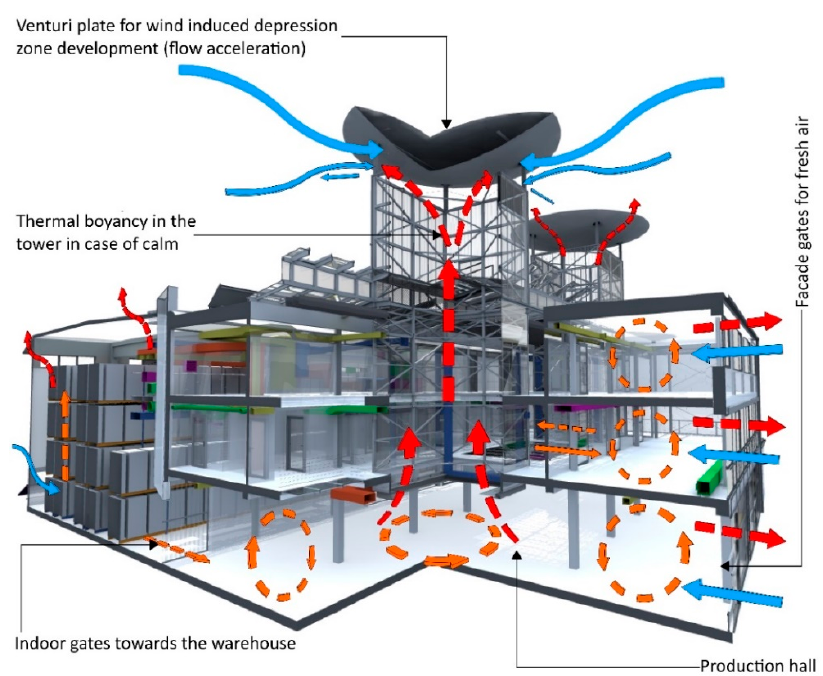
Figure 2. The passive air conduction system (PACS) concept of the prototype building.